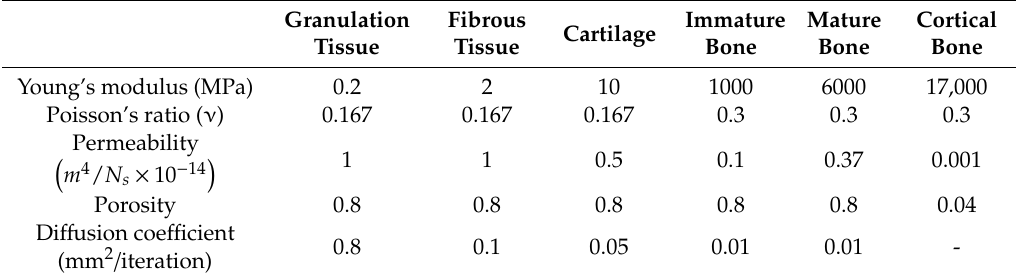
Figure 1. Schematic of the phenomenological axi-symmetric FE model of the knee including a femoral condyle, articular cartilage layer and meniscus for validation. Table 1. Material properties used in this